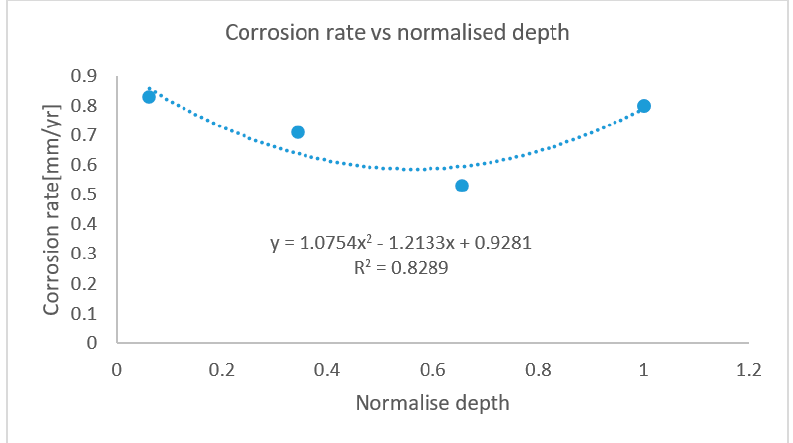
Figure 18. Normalised corrosion depth vs corrosion rates.